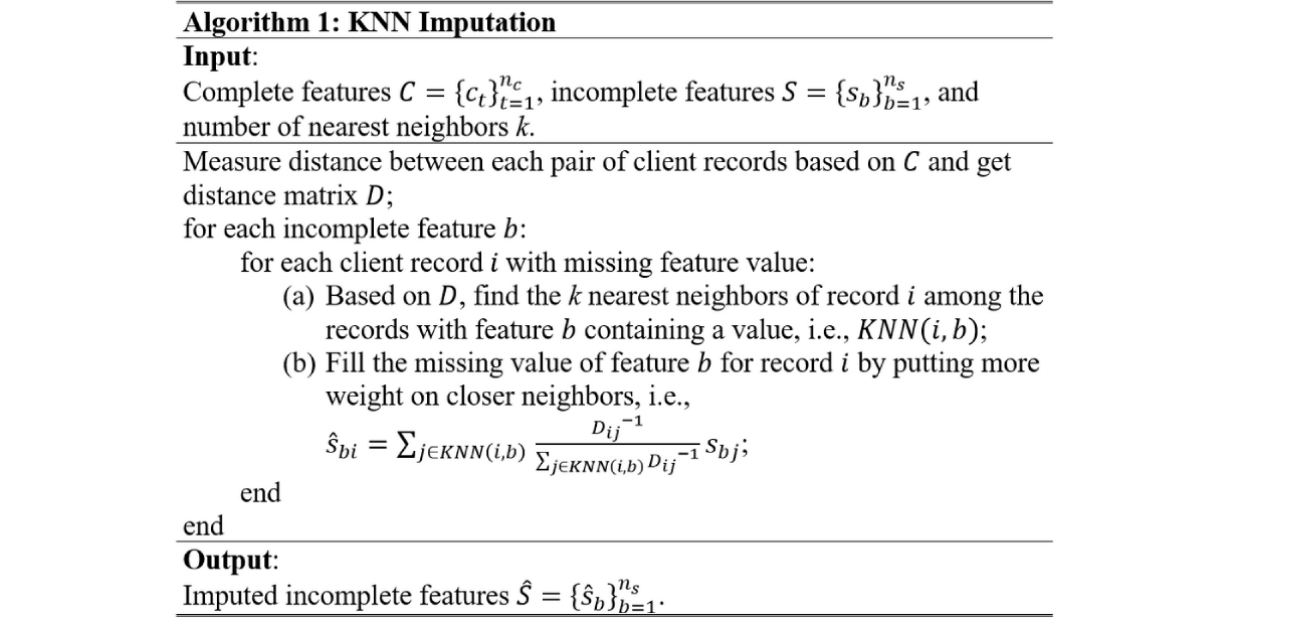
Figure 2. Algorithm of k-nearest neighbor imputation. KNN: k-nearest